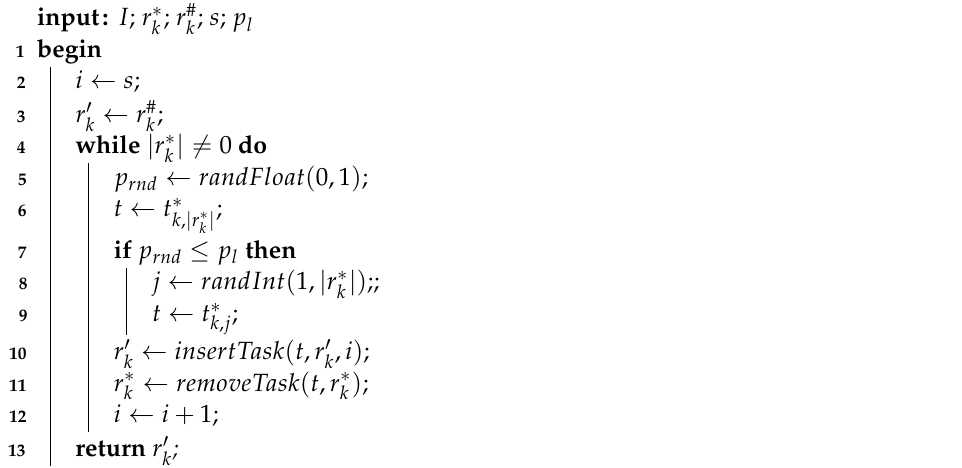
Algorithm 8: Distortion (algorithm of the distortion method within the sub-route plan